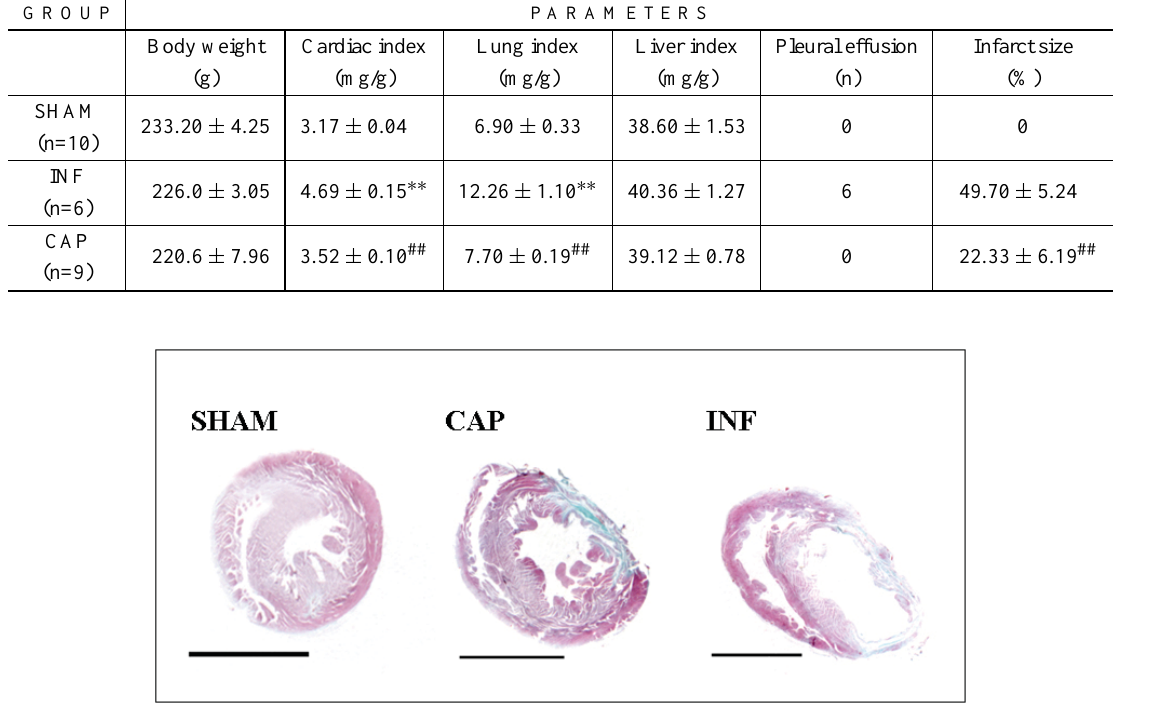
Fig. 2 – Representative cross section of heart slices at papillary level obtained from SHAM, CAP and INF 28 days after surgery. Note that captopril-treated rat showed a smaller scar tissue and left ventricular dilatation than non-treated rat. Bar = 0.5 cm. Tricromo gomori